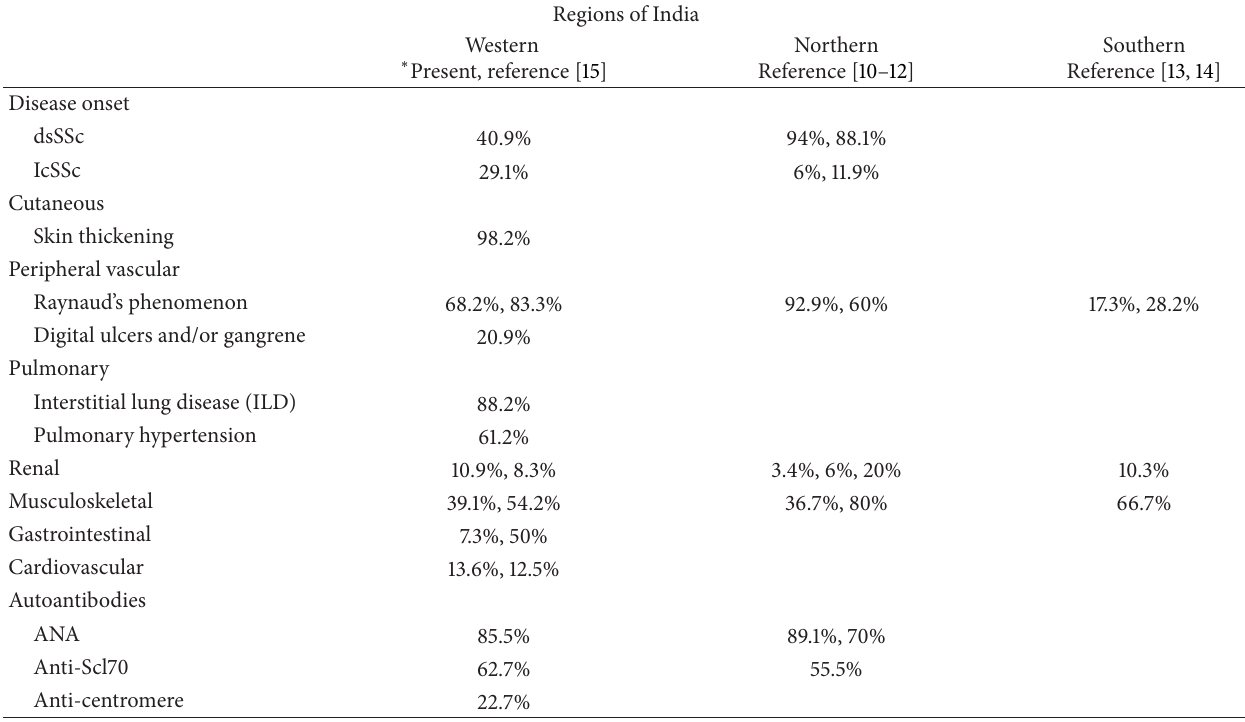
Table 4: Demographic and serological similarities/differences in Indian scleroderma patients in various regions across the